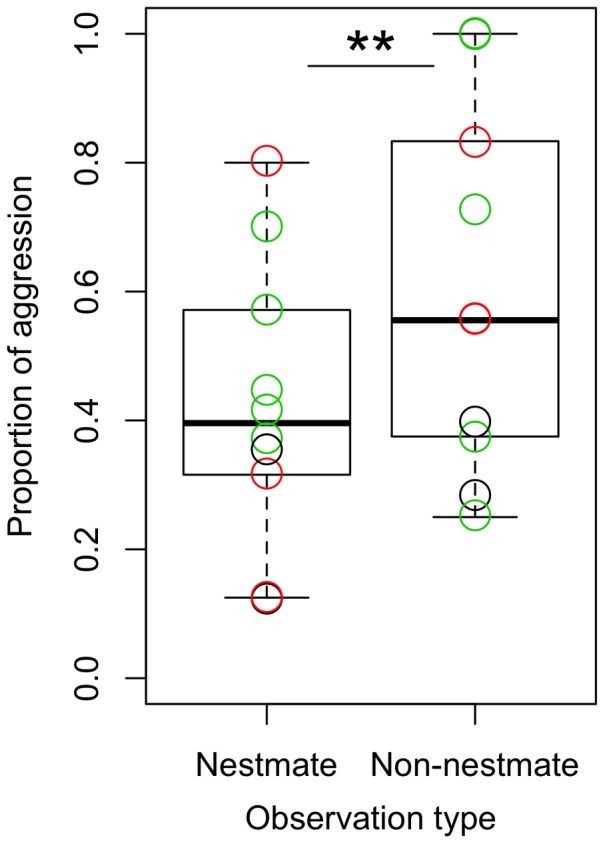
Proportion of aggressive behavior by Ca. femoratus in behavioral assays with nestmate and non-nestmate Ca. femoratus ants.Although Ca. femoratus was only of one chemotype, coloring is as in Figure 4 for consistency. The asterisks indicates there was significantly more aggression to non-nestmates (p<0.05).